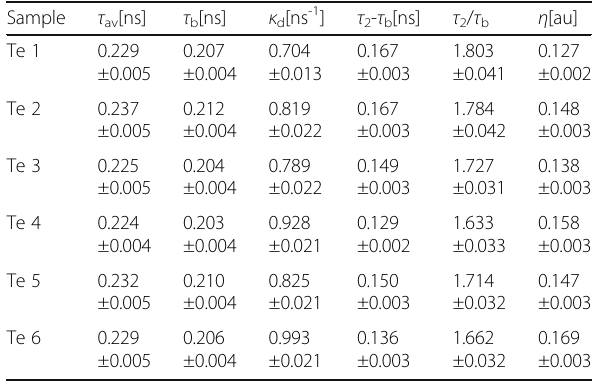
Table 3 Positron capture